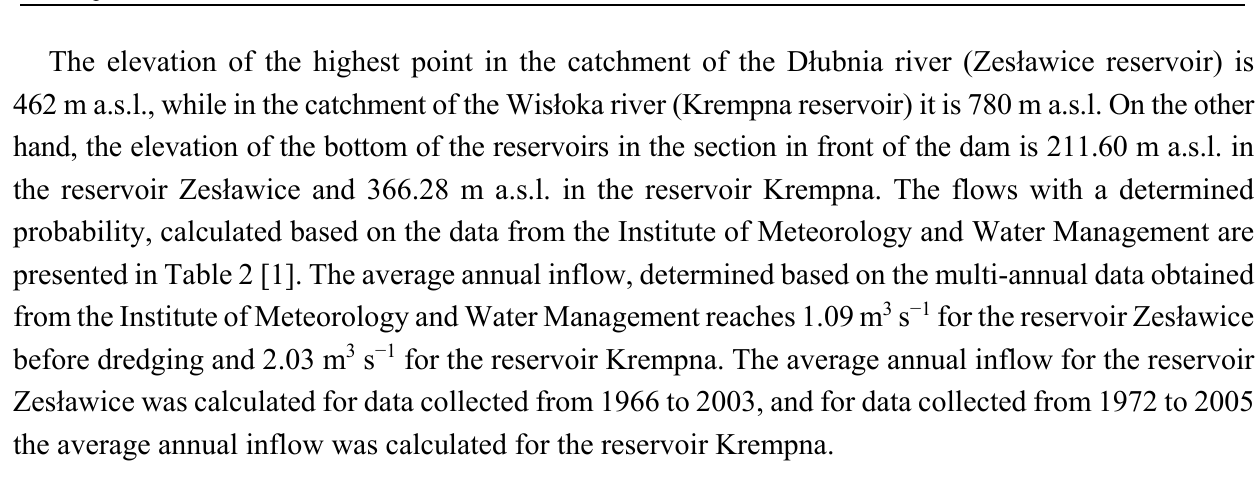
Table 2. The selected basic parameters of the